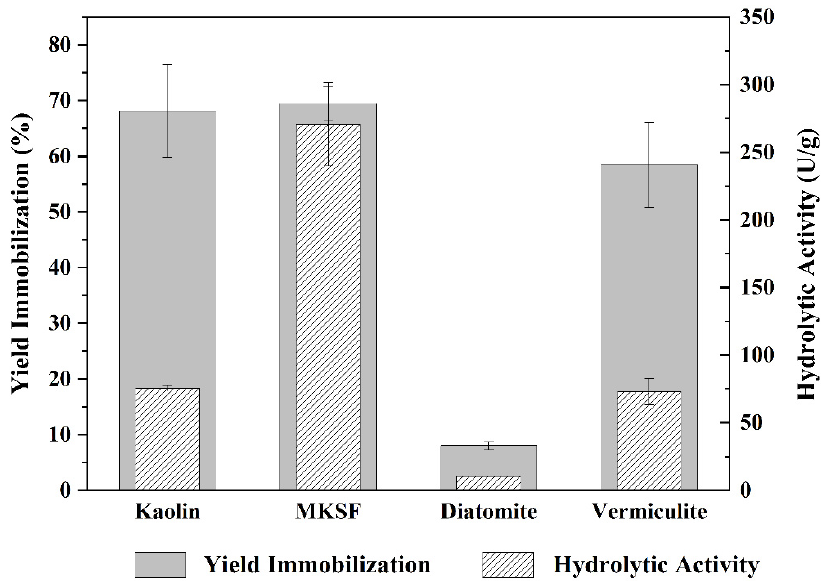
Figure 4. Enzymatic activity and immobilization yield of A. japonicus lipase immobilized on the supports: diatomite, vermiculite, montmorillonite KSF (MKSF) and kaolinite by physical adsorption. The error bars represent the standard deviation of triplicates.